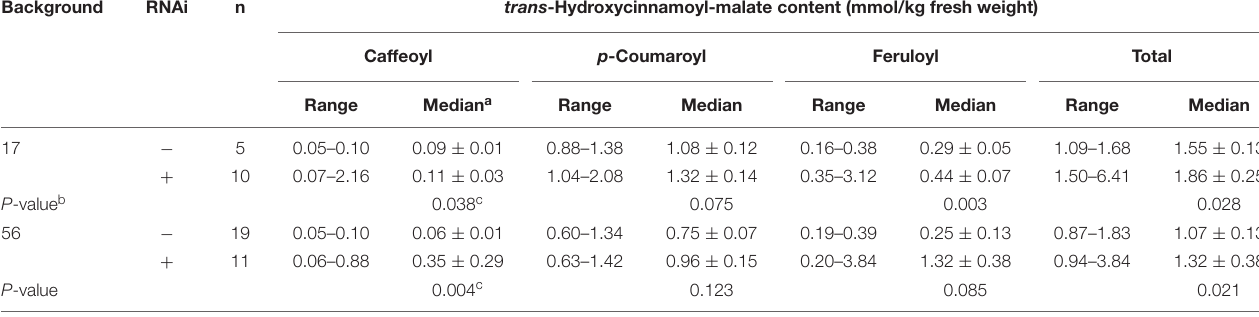
TABLE 3 | Accumulation of hydroxycinnamoyl esters in leaves of plants transformed with HMT and CCOMT RNAi or vector control. Background